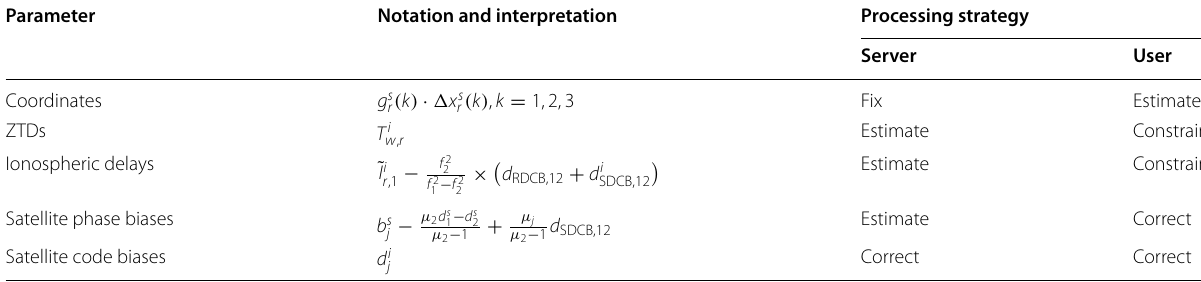
Table 2 Comparison of important PPP-RTK parameters and processing strategies between server and user sides